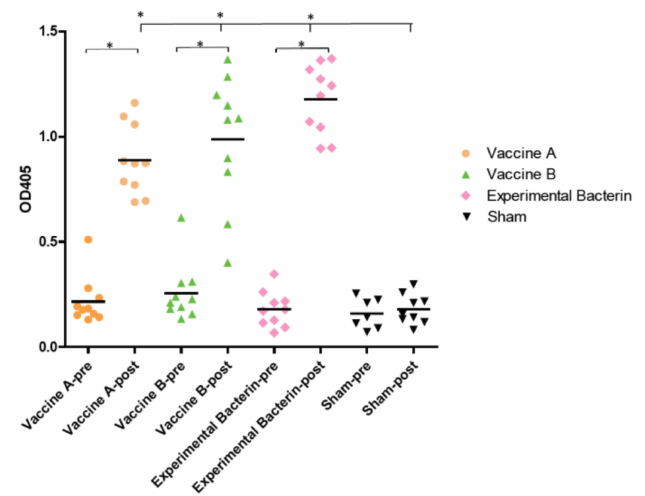
Figure 1. Vaccine-induced antibody levels against Campylobacter jejuni clone SA as determined